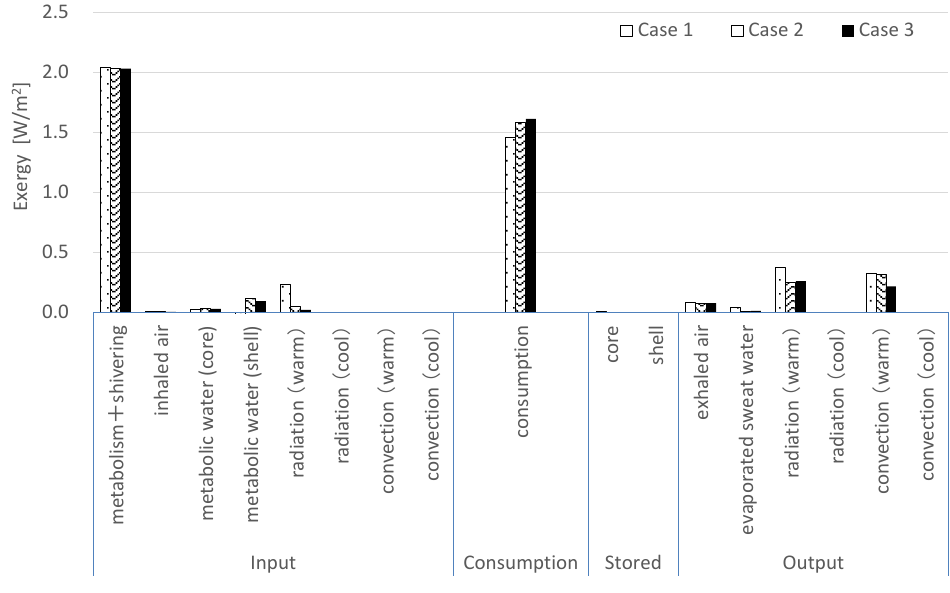
Figure 10. Elements of the human body exergy balance (August 2; 22:00 Local